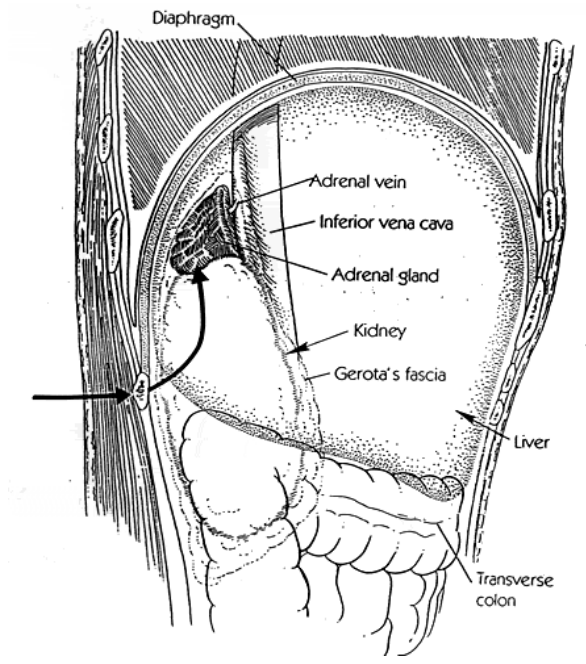
FIGURE 7 . Anatomical relationship of right adrenal and